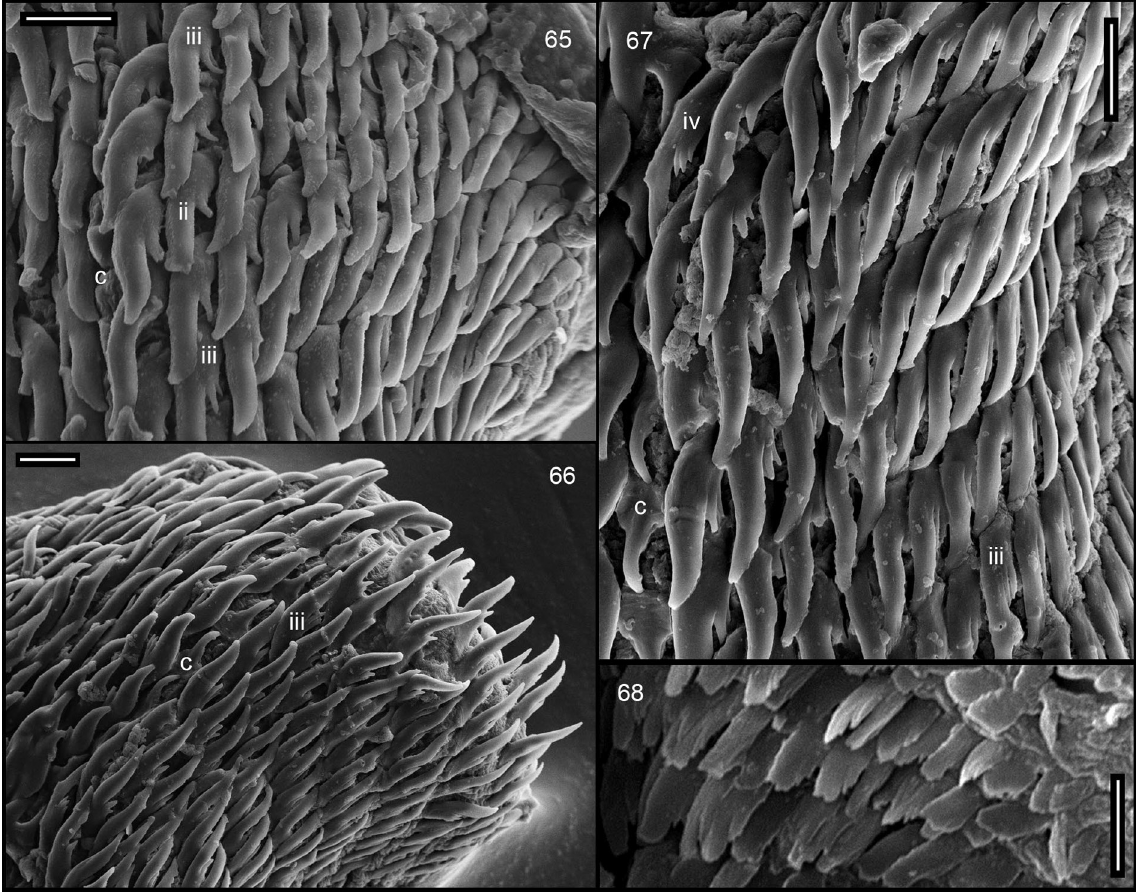
Figs 65-68. Radulae of Dadagulella gen. nov. species. 65. D. radius radius , Amboni. 66. D.